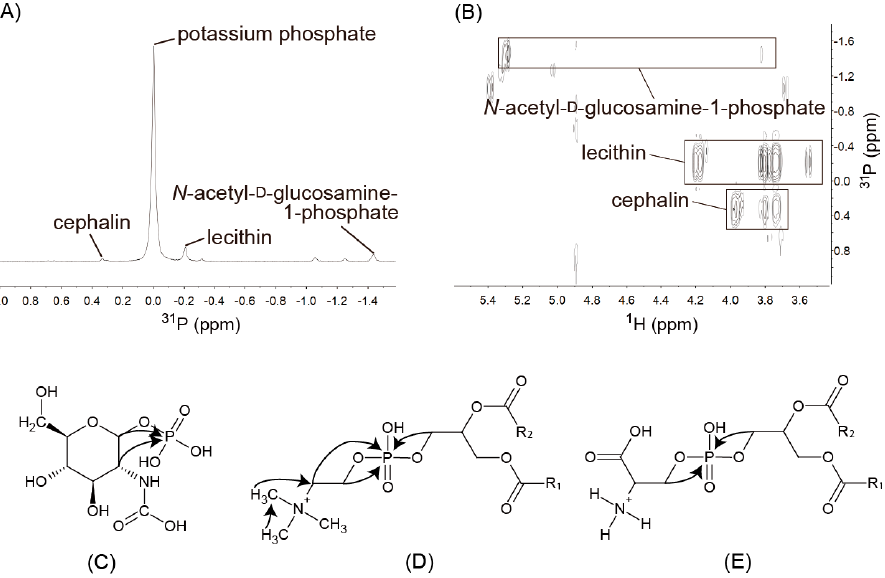
Figure 3. ( A ) The 31 P NMR spectrum of yogurt. ( B ) The 1 H- 31 P HMBC NMR spectrum of yogurt. ( C ‒ E ) Correlations of N -acetyl- D - glucosamine-1-phosphate ( C ), lecithin ( D ), and cephalin ( E ).